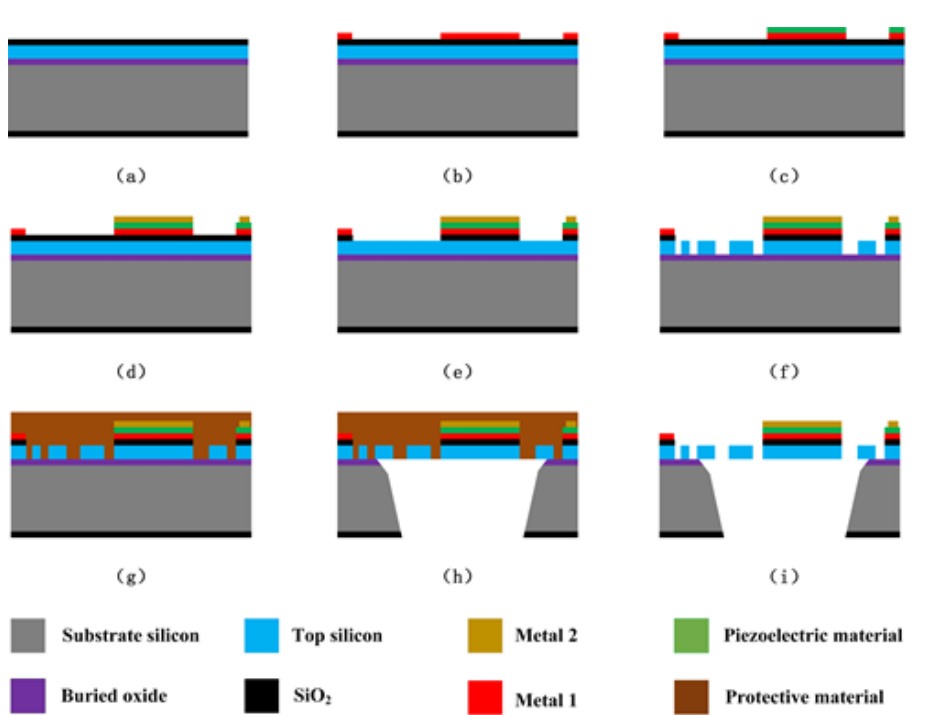
Figure 9. Main steps of the fabrication process. ( a ) Growing thermal SiO 2 . ( b ) Sputtering and patterning metal materials. ( c ) Depositing and patterning piezoelectric material. ( d ) Sputtering and patterning metal materials. ( e ) Patterning thermal SiO 2 . ( f ) Etching the top silicon layer. ( g ) Spin-coating protective materials. ( h ) Removing the oxides and etching the substrate silicon. ( i ) Removing protective materials.